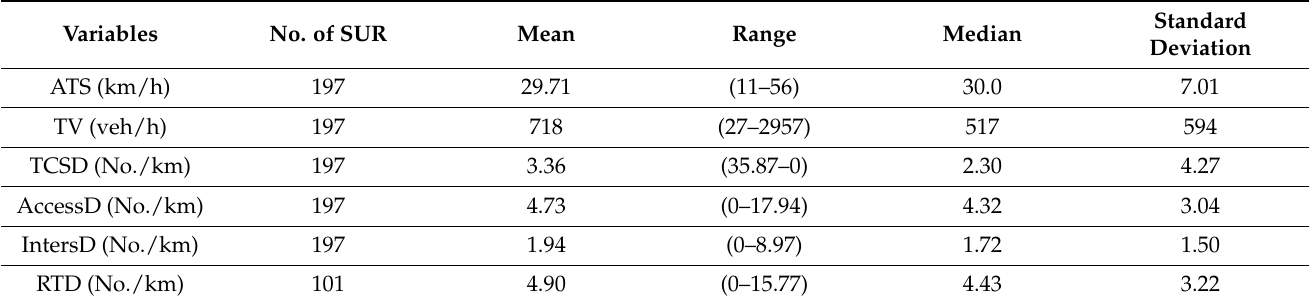
Table 4. Descriptive statistics of field-measured variables over surveyed urban roads (SUR).